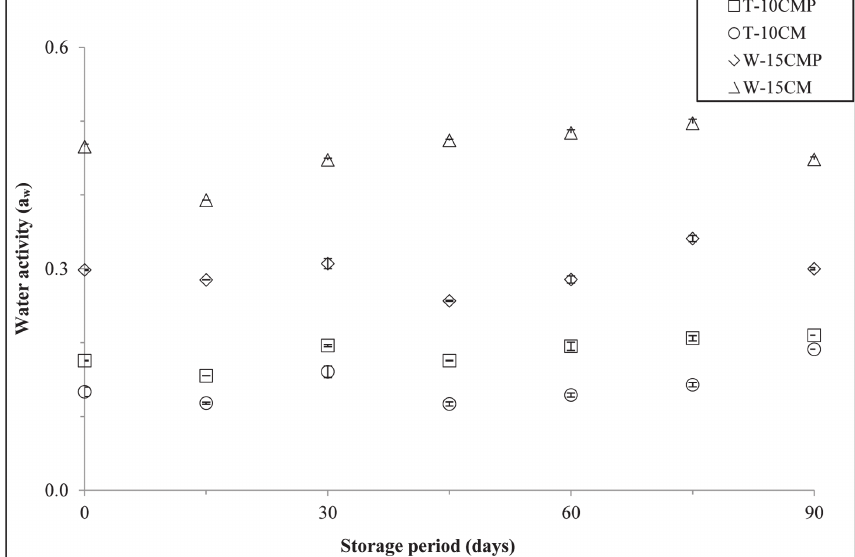
Figure 4 - Water activity values of enriched